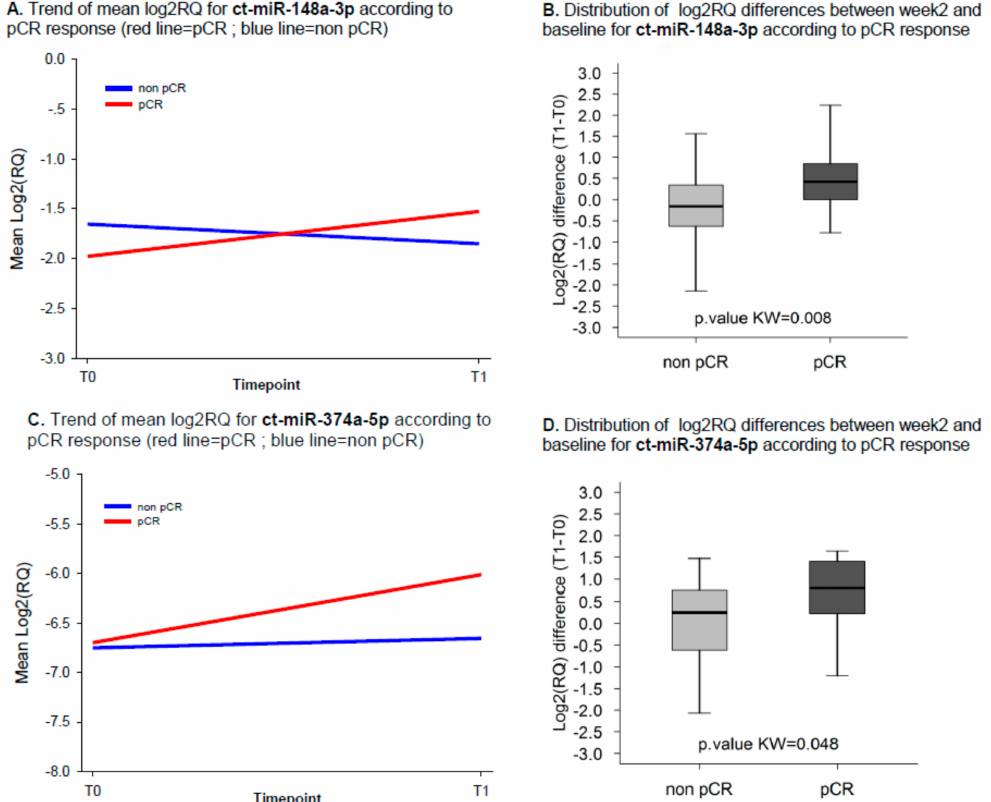
Figure 2. Trend of mean log 2 RQ and distribution of the di ff erence between week 2 and baseline according to pCR for ct-miR-148a-3p and ct-miR-374a-5p. Panel ( A , C ) report the trend of mean log 2 RQ for ct-mR-148a-3p and ct-miR-374a-5p according to pathological complete response (pCR), respectively. Panel ( B , D ) report the distribution of the di ff erence between log2RQ of each ct-miRNA at T1 and T0 according to pCR. Red line indicates patients with pCR and blue line indicates patients without pCR. Panels ( B , D ) report the distribution of log2RQ di ff erence between week 2 and baseline for ct-mR-148a-3p and ct-miR-374a-5p according to pCR, respectively. p -Value of the Kruskal-Wallis test for the comparisons of log2RQ di ff erence between patients with and without pCR is